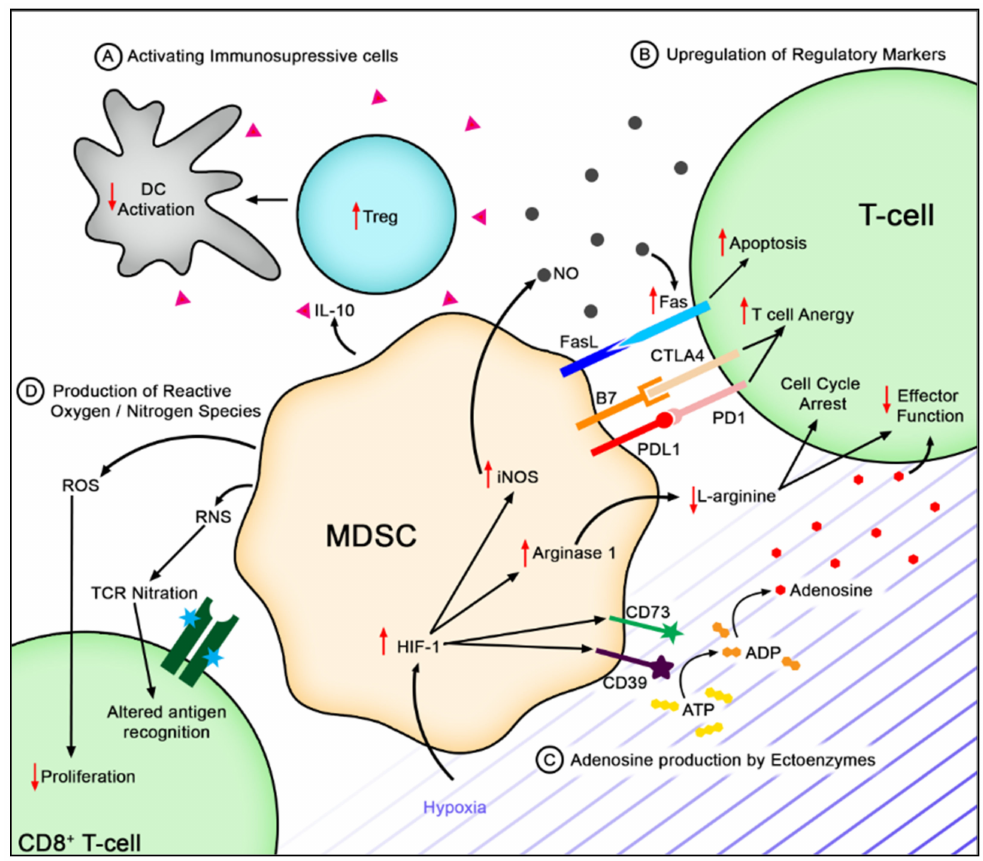
Figure 1. Mechanisms of Immunosuppression in the tumor microenvironment. ( A ) MDSCs activate immunosuppressive cells such as Tregs via IL-10 secretion. These cells can dampen antigen presenta- tion capabilities by dendritic cells, which leads to reduced T-cell activation. ( B ) MSDCs can induce the upregulation of checkpoint molecules such as CTLA4 and PD1 on T-cells, further inducing T-cell anergy, or Fas that can induce T-cell apoptosis. ( C ) Hypoxia in the tumor microenvironment can induce the upregulation of CD73 and CD39 that increases adenosine. ( D ) MDSCs produce ROS and RNS that can decrease T-cell proliferation and alter antigen recognition capabilities. CD8 + T-cells and induced the formation of